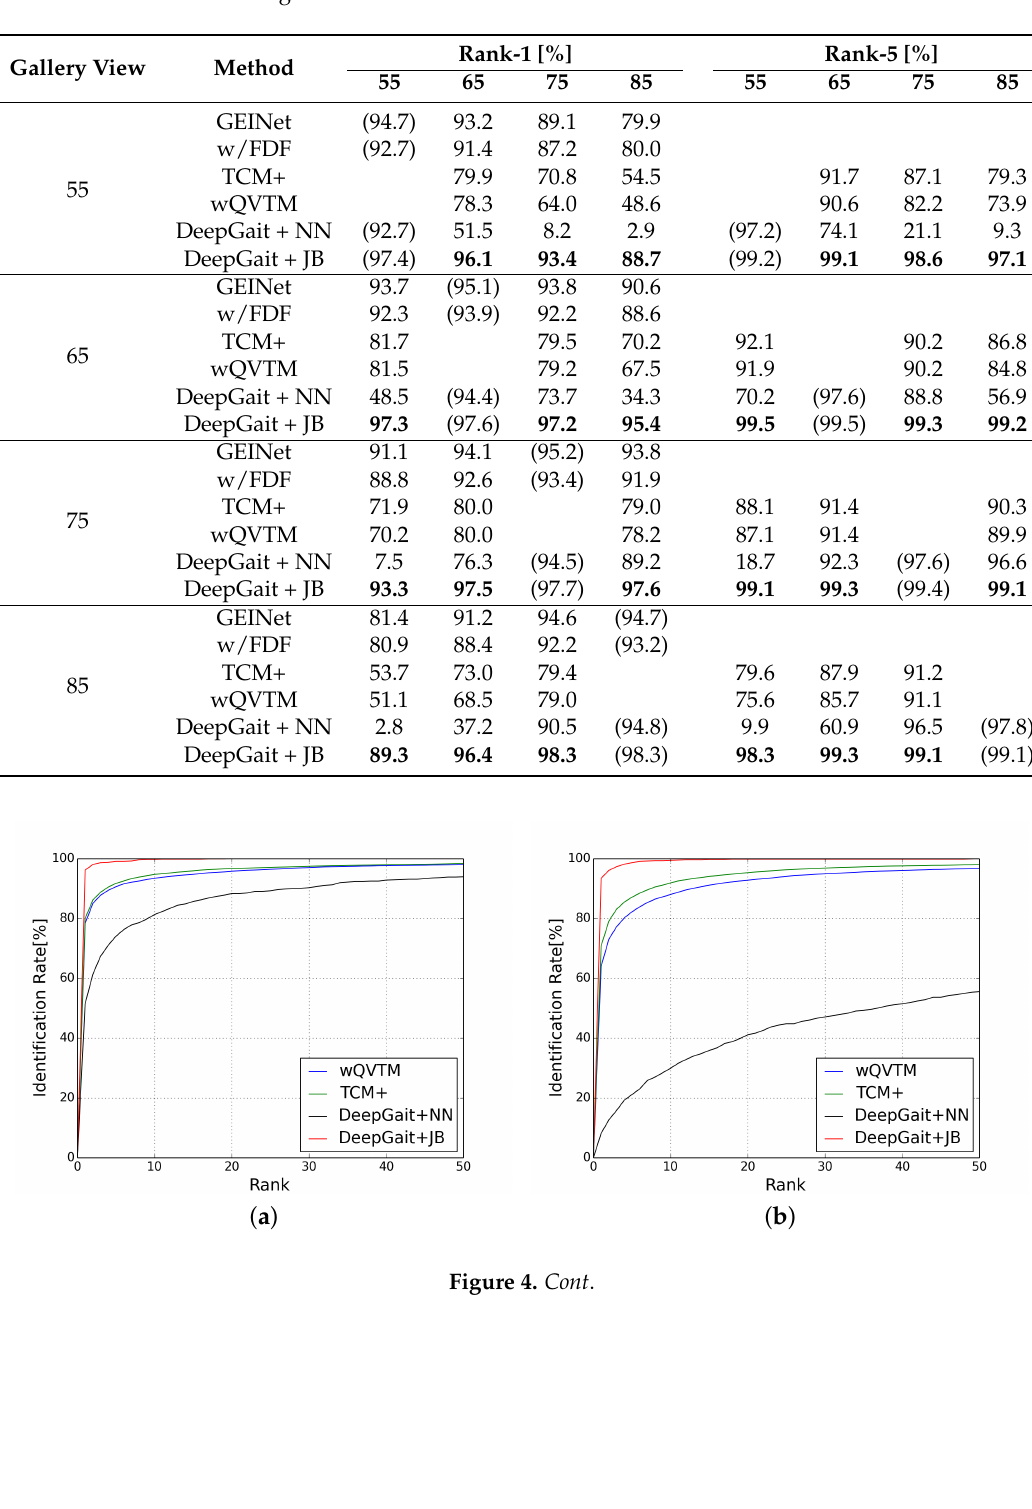
Table 2. Comparison of rank-1 (%) and rank-5 (%) identification rates with other existent methods in different cross-view